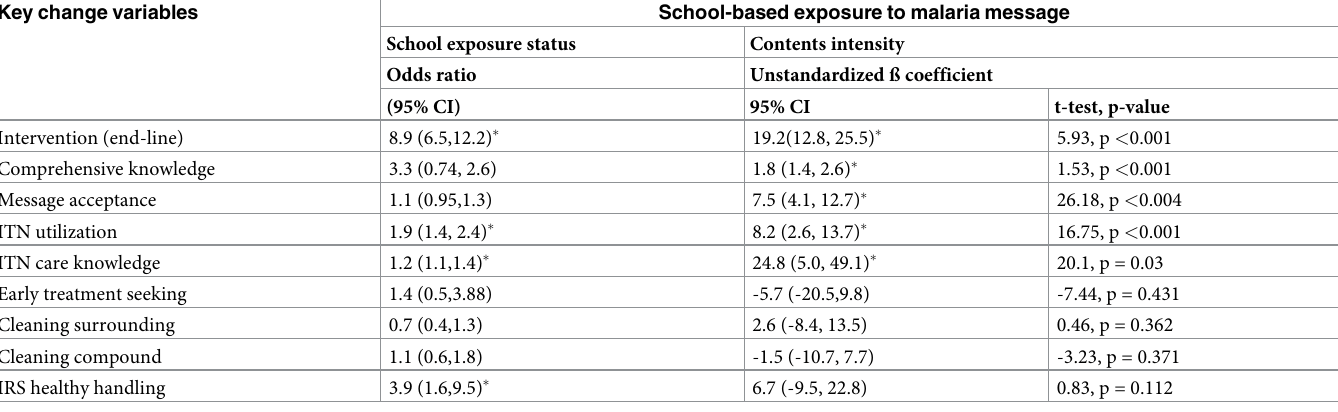
Table 7. School-based exposure to malaria messages and relationship with key variables of change, Jimma zone, SBCC target districts, 2017–2019, Ethiopia. Key change